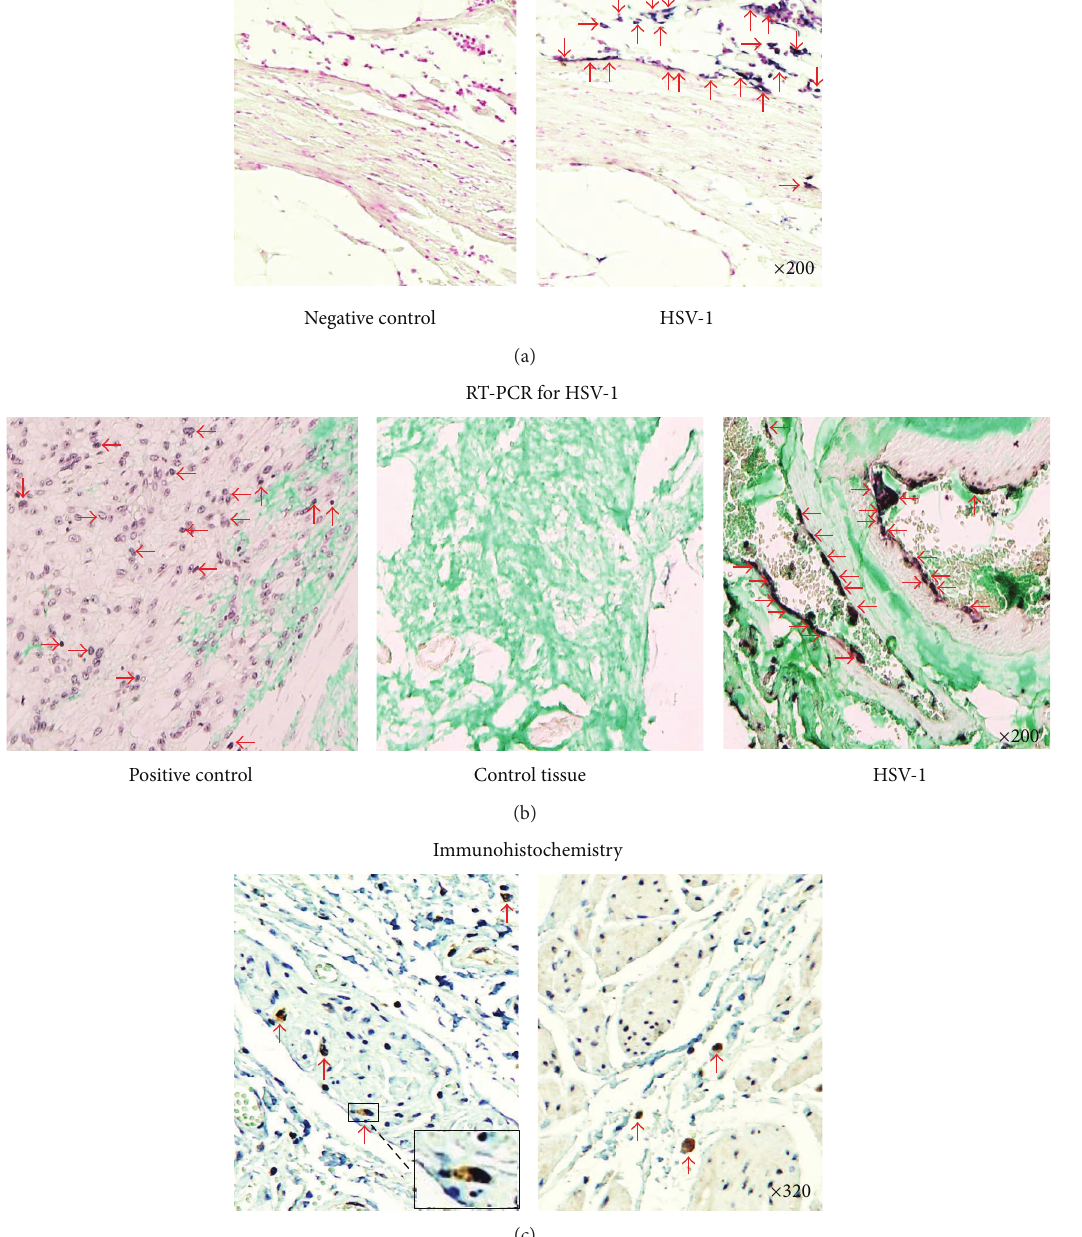
Figure 7: HSV-1 identification. (a) In situ hybridization. Arrows depict achalasia tissue with viral infection. (b) In situ RT-PCR for active replication of HSV-1. Arrows show antigen detection of HSV-1 infected cells in a skin lesion (positive control) and achalasia tissue. Original magnification was × 200. (c) Immunohistochemistry for antigen HSV-1 detection. Arrows depict immunoreactive cells. Original magnification was ×